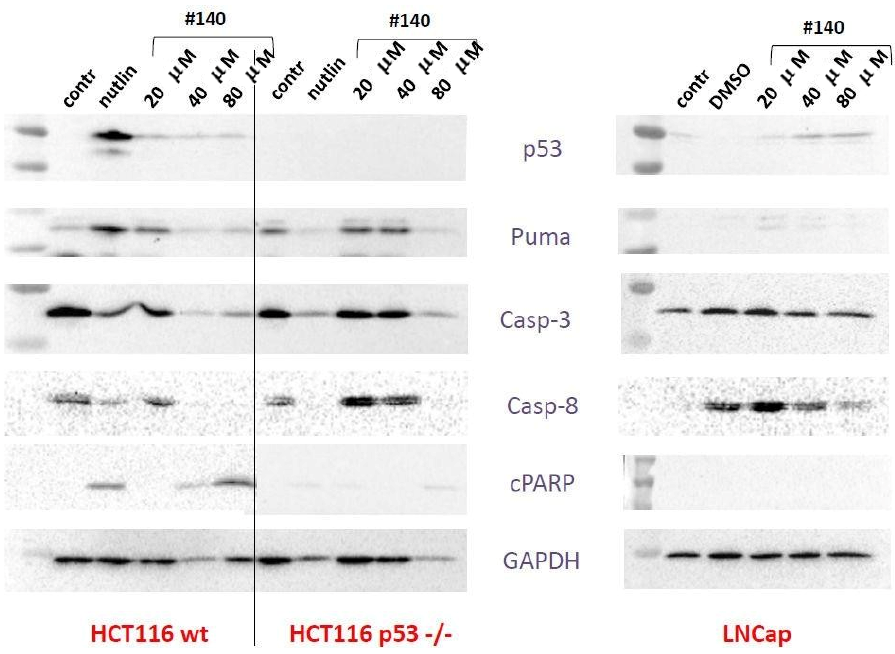
Figure 8. Western blot data showing the effects of compound 29 on the expression of the p53 and PUMA proteins, as well as caspase-3 and caspase-8—caspases involved in p53-dependent apopto- sis in HCTwt, HCT ( − / − ) ,and LNCaP cells. Nutlin-3a (20 µM) was used as a positive